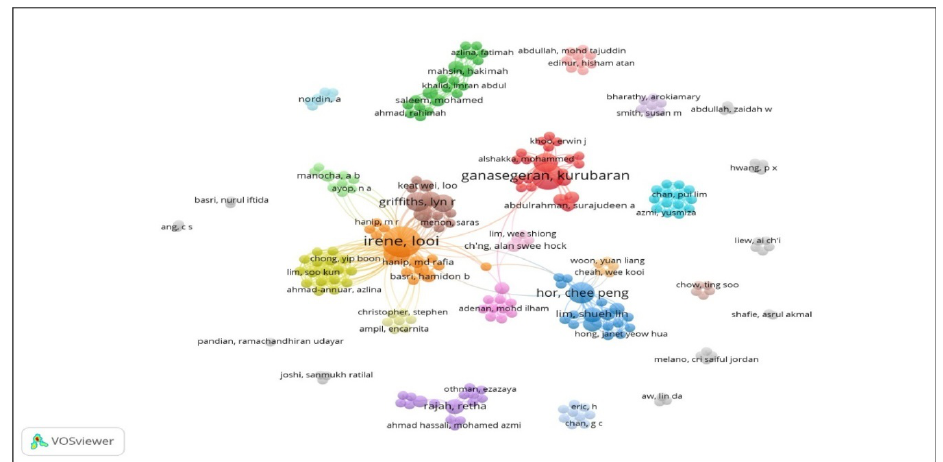
Figure 2. Radar chart showing network of clinician’s co-authorships of publication output. Threshold set at ≥ 1 publication. The size of the circle represents the density of productivity output and the thickness of the connecting lines represents collaboration strength.